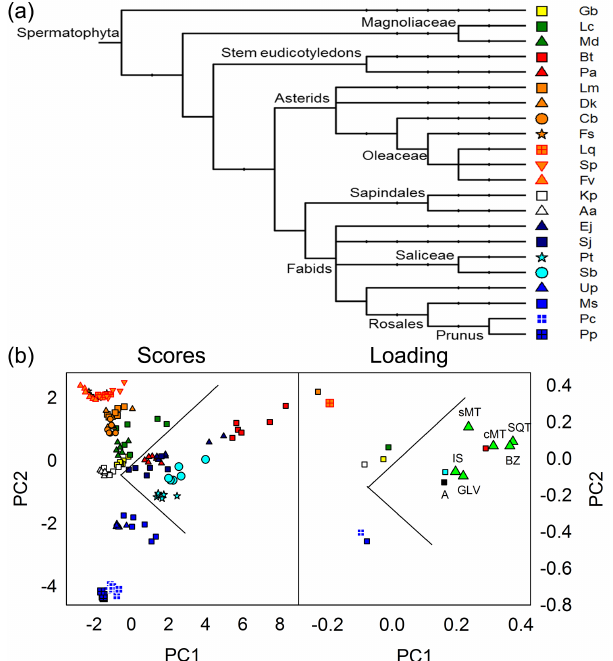
are given only 3